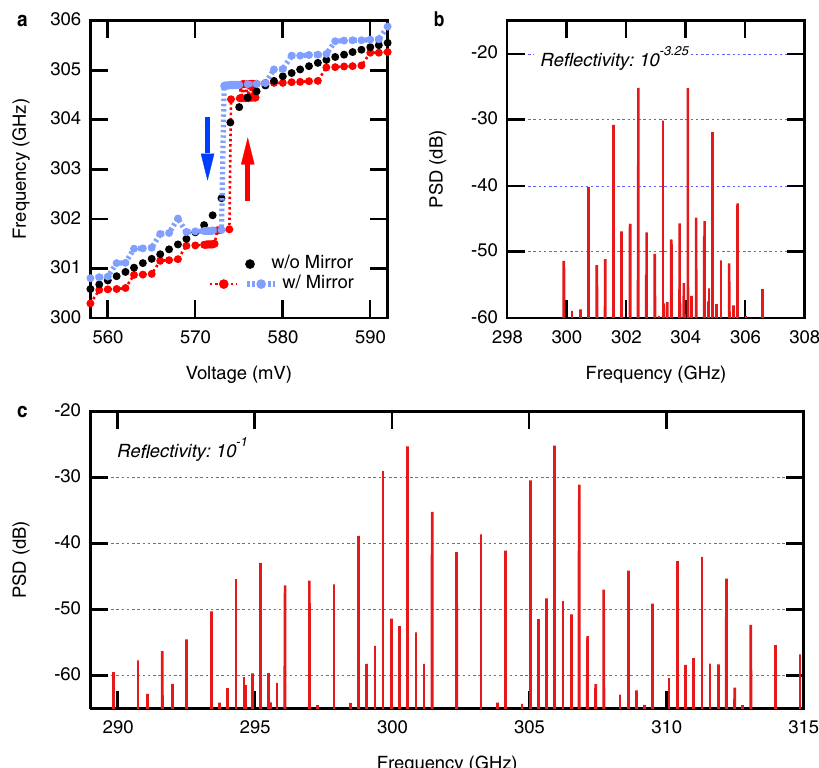
Fig. 4 Circuit simulation. a Wide-range frequency-voltage characteristics. In the simulation, the temporal waveform was calculated by sweeping the bias voltage. At each data point, the voltage sweep was stopped, and the temporal waveform was simulated for 0.62 µ s. The spectrum was obtained by Fourier transforming the temporal waveform of the last 0.1 µ s. The shot noise described in Supplementary Note 8 (1) was included. b Harmonic frequency-comb ¼ 10 (cid:3) 3 : 25 , which corresponds to the experimental condition. c Harmonic frequency-comb spectrum simulated for spectrum simulated for re fl ectivity η Mirror η ¼ 10 (cid:3) 1 . Since the circuit has a nonradiative loss, it corresponds to the case where all the emitted power is fed back from the mirror. The results in Mirror panels b and c obtained under the following conditions: the bias voltage was 573.5 mV. The temporal waveform was simulated over 11.0 µ s, and the spectrum was calculated using the last 1.0 µ s. Noise had a standard deviation 10 times smaller than the shot